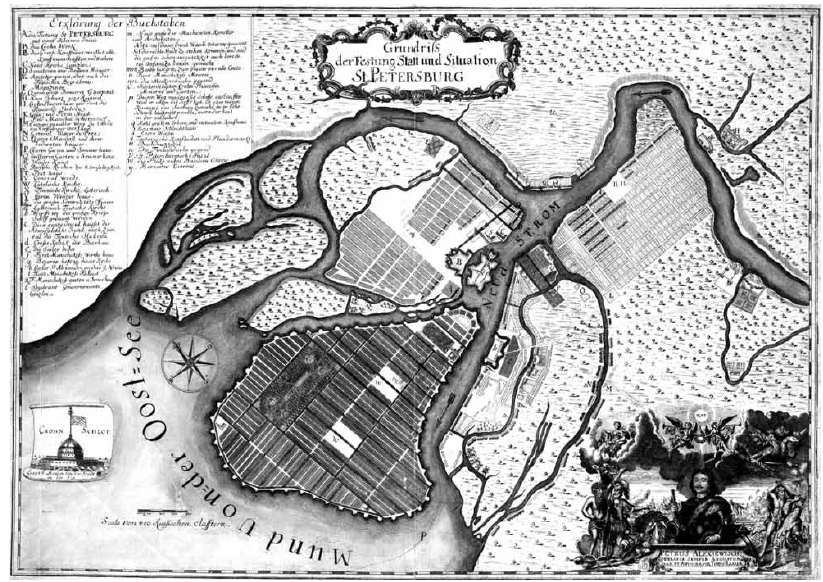
fig. 2. Developed plan for Saint Petersburg,